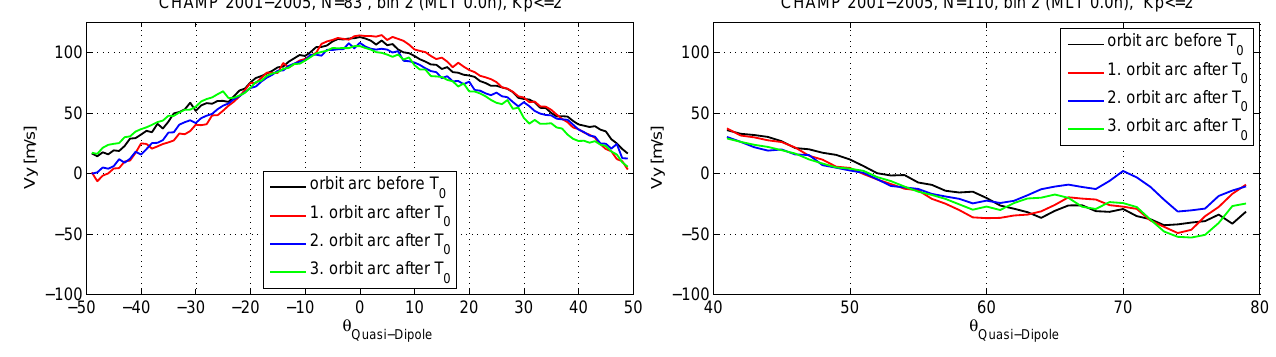
Fig. 8. same as Fig. 7, but for low magnetic activity (Kp ≤ 2). Calculated mean MLT: